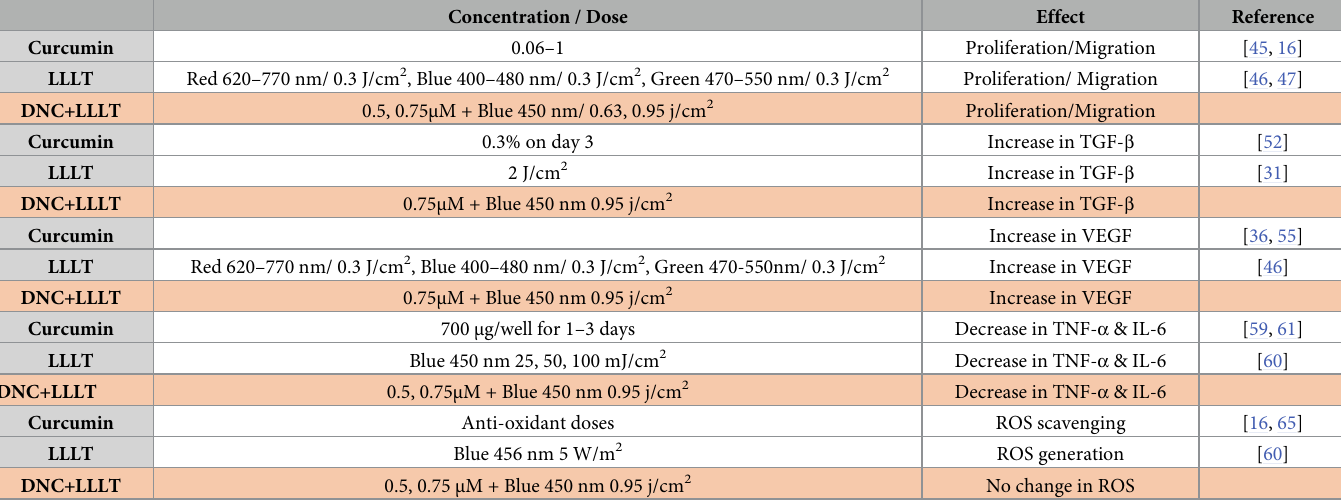
Table 1. The comparison of our findings with the previous research results in more